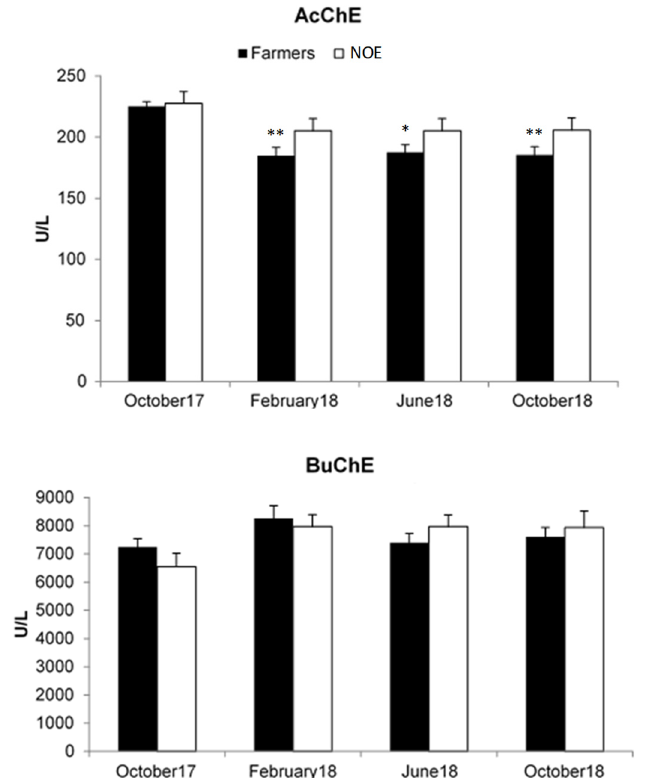
Figure 1. Activities of AChE in erythrocyte and BuChE in serum evaluated at different sampling times. Data are expressed as the mean ± standard error of the mean (SEM). * p < 0.05; ** p < 0.01 versus farmers (October17). AChE: acetylcholinesterase; BuChE: butyrylcholinesterase; NOE: non- occupational exposed.